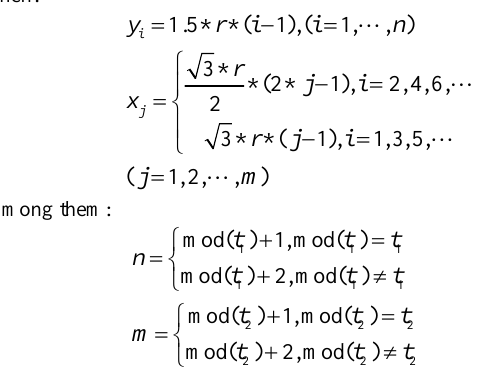
Figure 4. Regional subdivision overview diagram